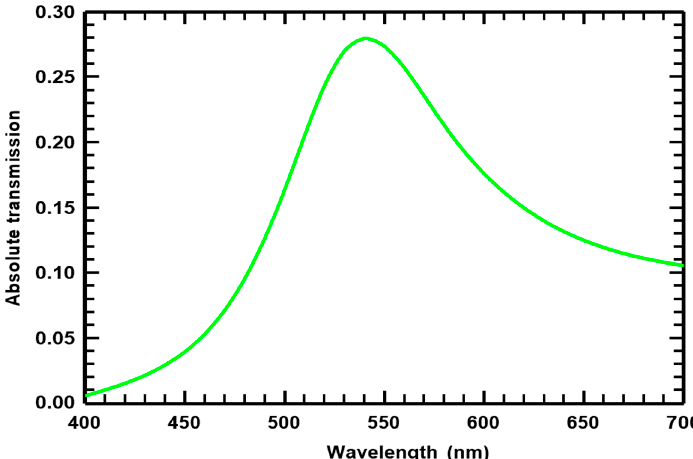
Figure 3. Transmission characteristics of CH-based green filter after tuning both localized and surface plasmon resonances.